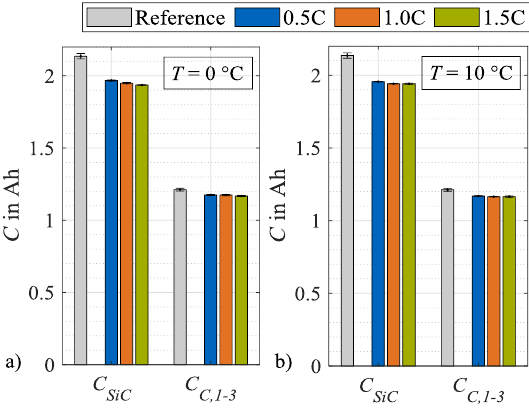
Figure 11. Absolute changes in characteristic capacities after load cycle 14 at ( a ) 0 °C and ( b ) 10 °C. Additional insights on the contribution of silicon and graphite on the anode degradation can be drawn from the DVA spectra, which are displayed in Figure 12. Excerpts from the full spectrum ranges are shown for both load temperatures that focus on the capacities C SiC and C C ,1 . The increased silicon graphite peaks related to the capacity C C ,1 . In combination, the silicon peaks related to C SiC rise in a vertical direction with increasing charge rate and cycle number. Basically, higher values in d U /d Q